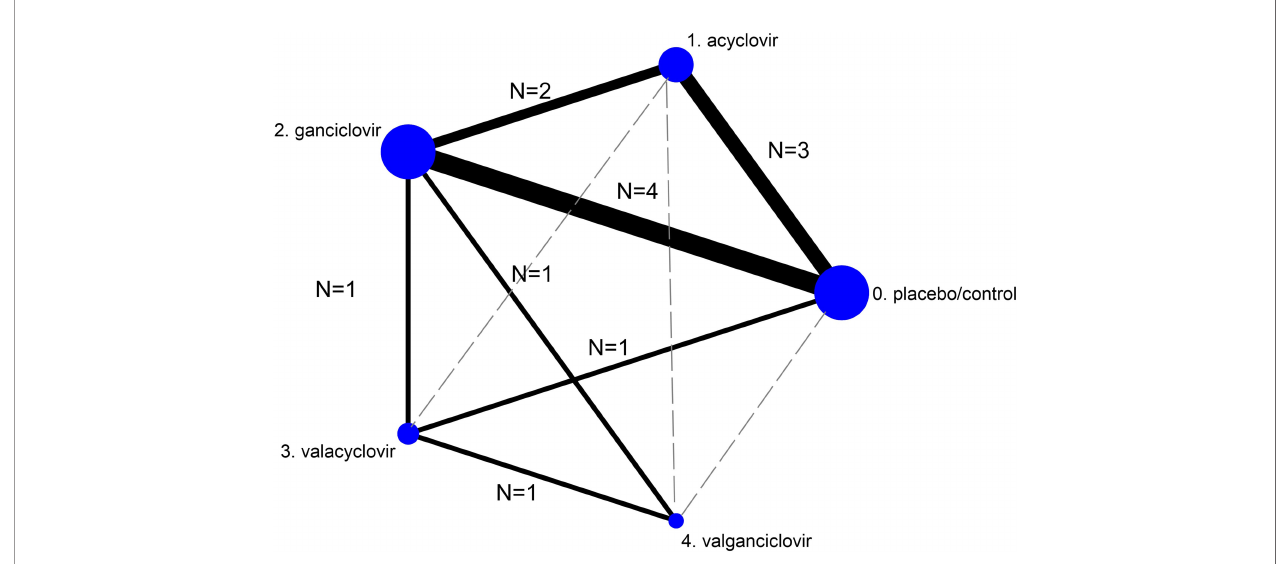
FIGURE 2 | Network meta-analysis of eligible comparisons for ef fi cacy (incidence of biopsy-proven acute rejection). The fi gure plots the network of direct comparisons (black bold lines) and indirect comparisons (dashed line). The width of the lines is proportional to the number of trials comparing every pair of treatments. The size of each circle is proportional to the number of randomly assigned participants (sample size).